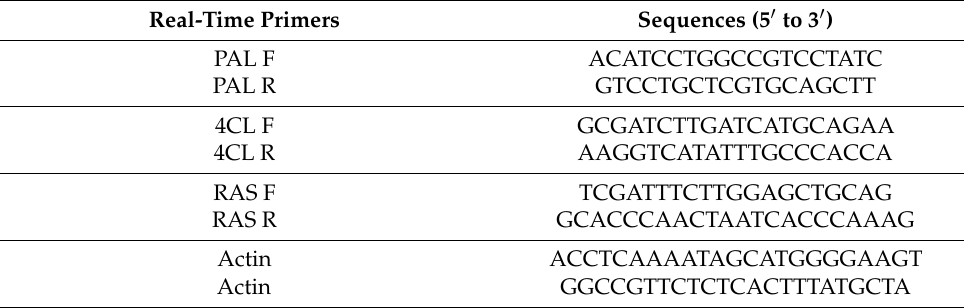
Table 1. Primers applied to real-time PCR